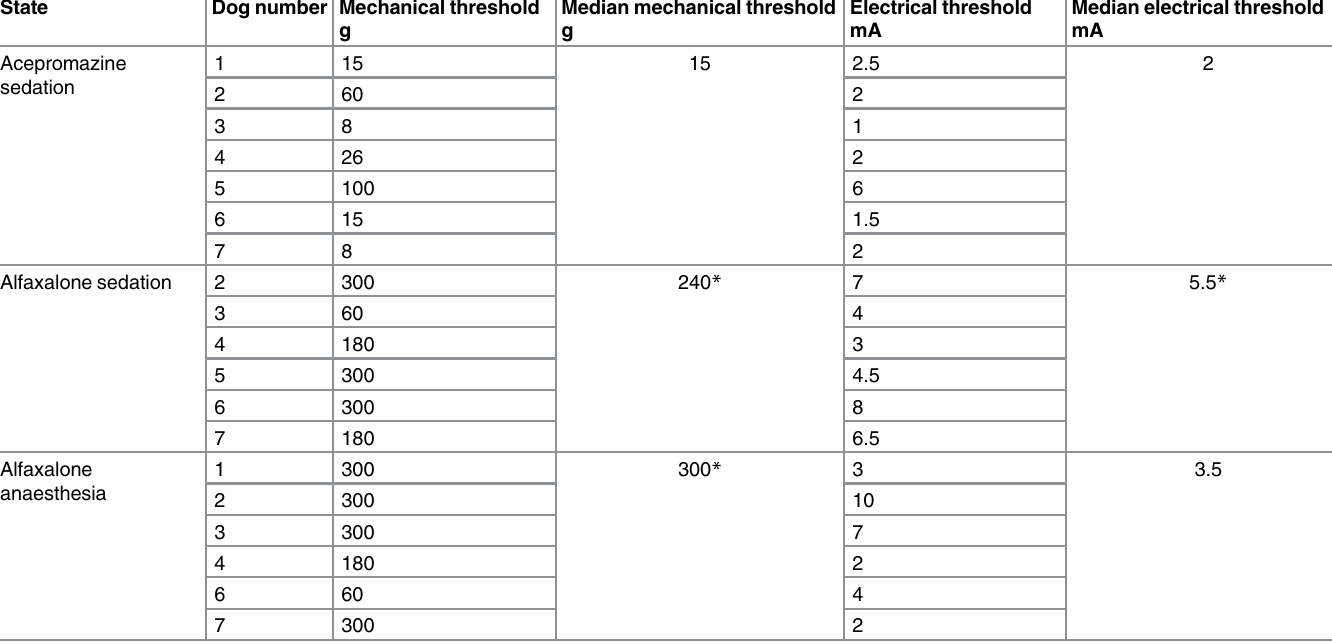
Table 1. Mechanical and electrical threshold recordings from the three states. * P = 0.01 compared to acepromazine threshold. State Dog number Mechanical threshold Median mechanical threshold g